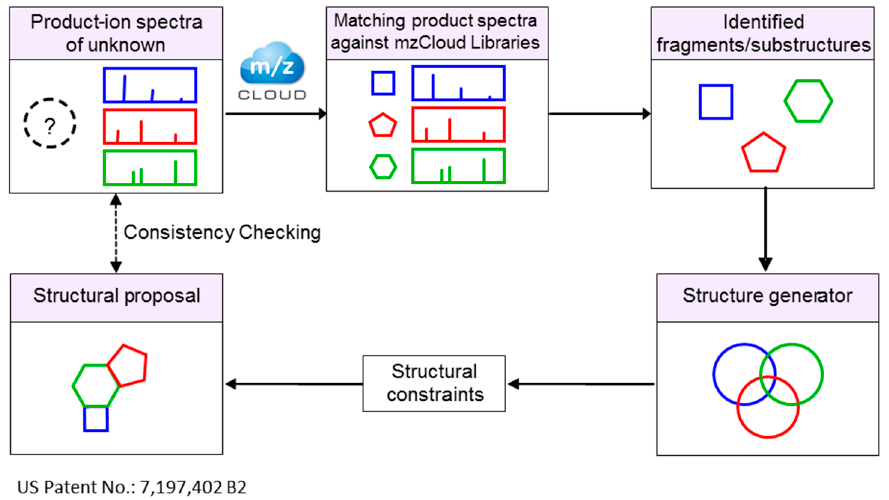
Figure 2. Strategy for structure elucidation for unknown metabolites using mzCloud library of mass spectral fragments/substructures.